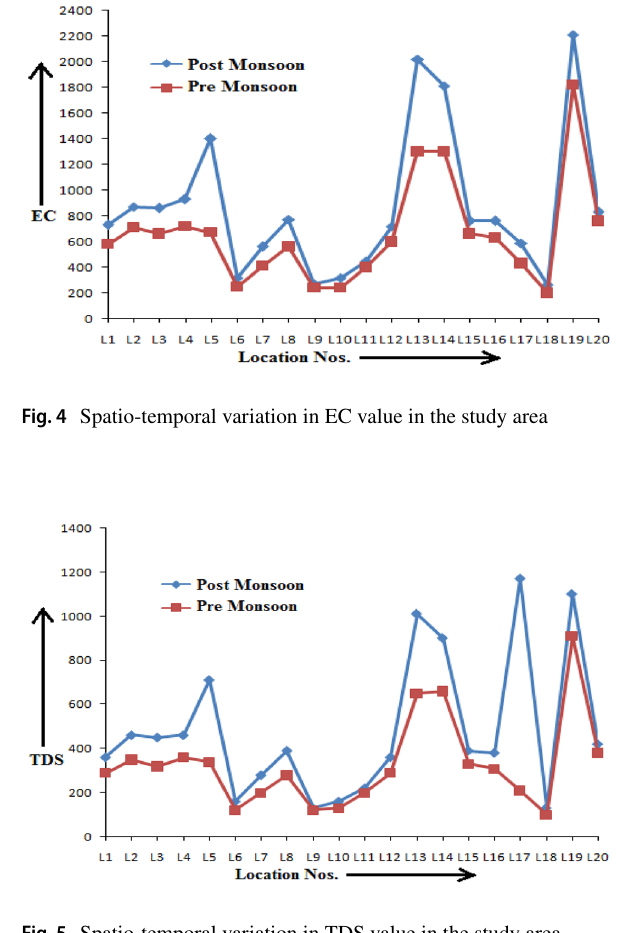
Fig. 5 Spatio-temporal variation in TDS value in the study